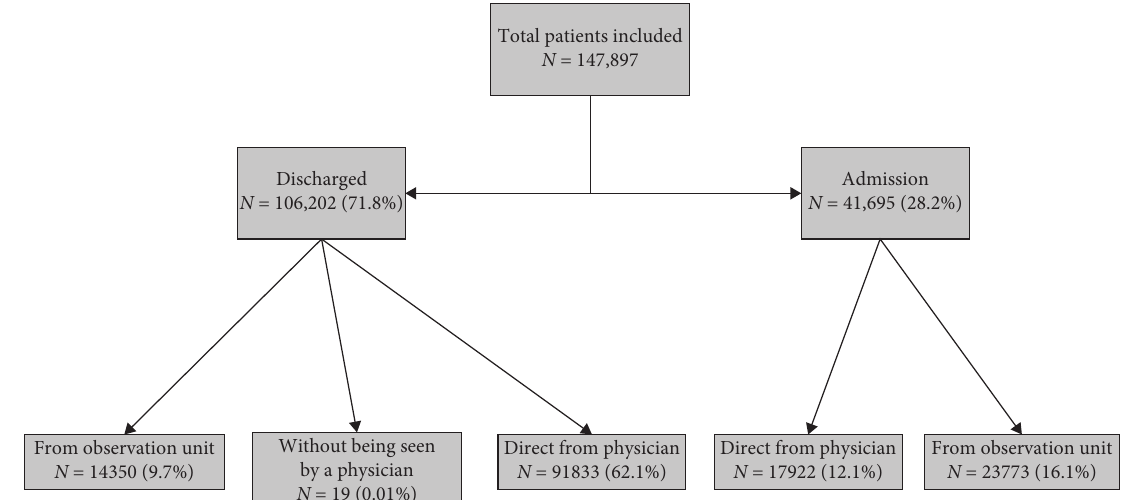
Figure 2: Diagram of patient flow with proportion.